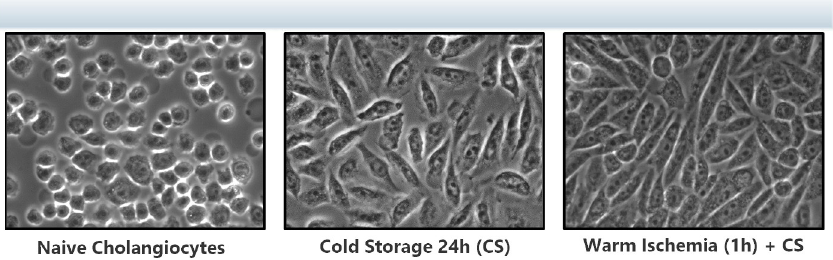
Fig 2. Cholangiocyte morphology changes. Light microscopic appearance of cultured cholangiocytes before or after cold storage (24 hours) and warm ischemia (1 hour). Panel 1 shows Naive cholangiocytes: Normal cuboidal epithelial cell appearance; Panel 2 shows 24-hour cold storage cells: Mixed cell shapes from cuboidal towards spindle-shaped cell; Panel 3 shows cells exposed to both cold storage and 1 hour of warm ischemia: Mostly spindle mesenchymal cell appearance with loss of cuboidal architecture in any cells. The normal cuboidal epithelial appearance has been replaced by a spindle shaped mesenchymal appearing cell morphology in response to DCD ischemic conditions. Magnification =